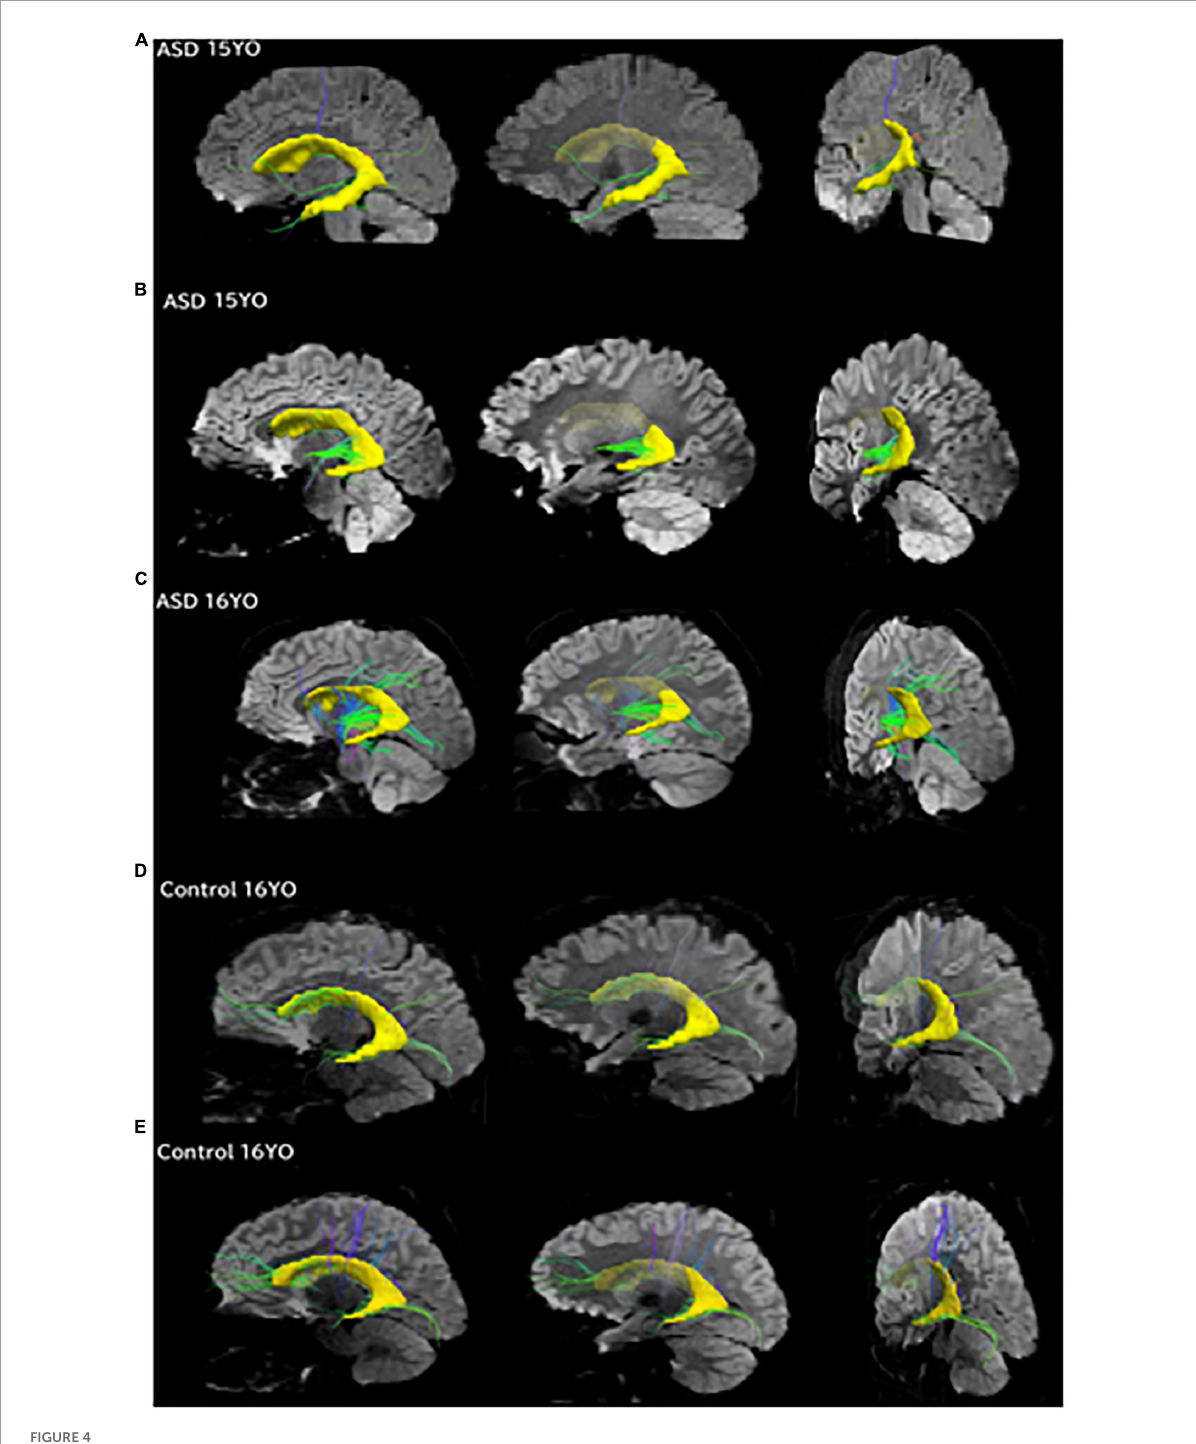
FIGURE4 Pathways between the posterior SVZ and the insula were absent or fewer in controls compared to ASD patients. Tractography pathways from the entire SVZ (yellow) in patients with ASD and control at three different slices. (A) 15-year-old with ASD; (B) 15-year-old with ASD; (C) 16-year-old with ASD; (D) 16-year-old control; (E) 16-year-old control. Images from each patient are shown at mid-sagittal slices (left column), lateral sagittal slices at the level of the insula (middle column), and posterior oblique views with mid-sagittal slices and coronal slices at the level of the insula (right column) are shown.